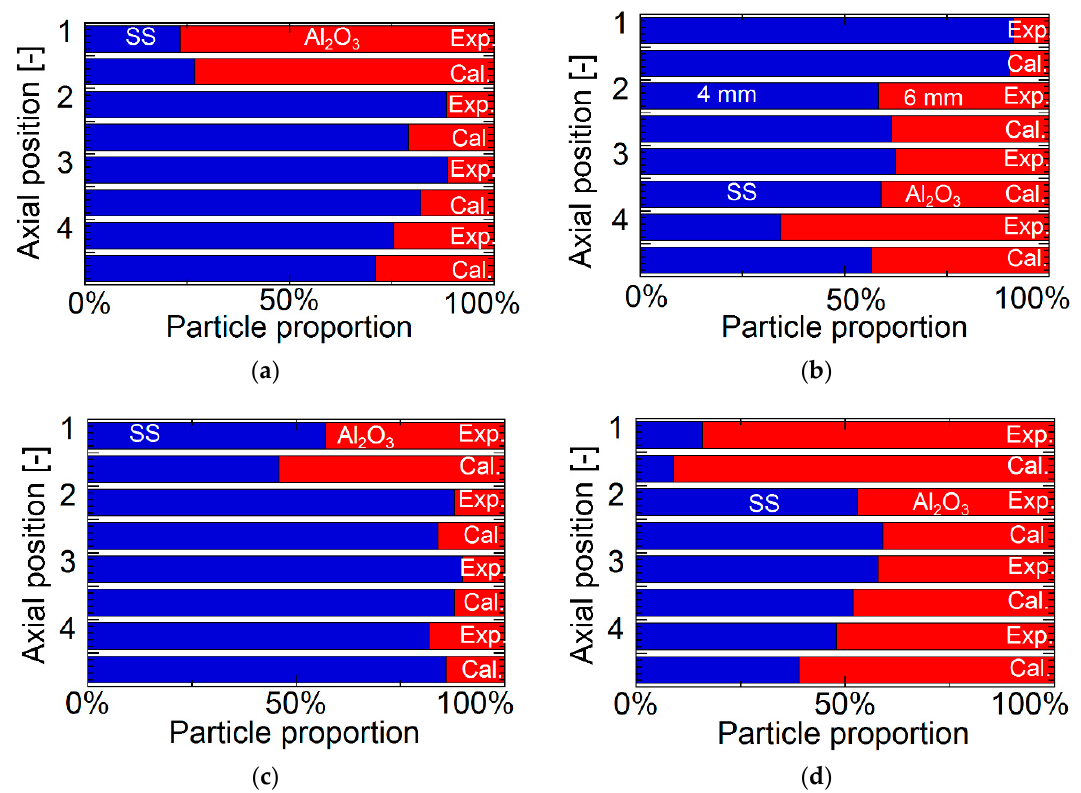
Figure 8. Particle distribution at four axial positions in the mixed particle bed: ( a ) Case M1; ( b ) Case M2; ( c ) Case M4; ( d ) Case M5.